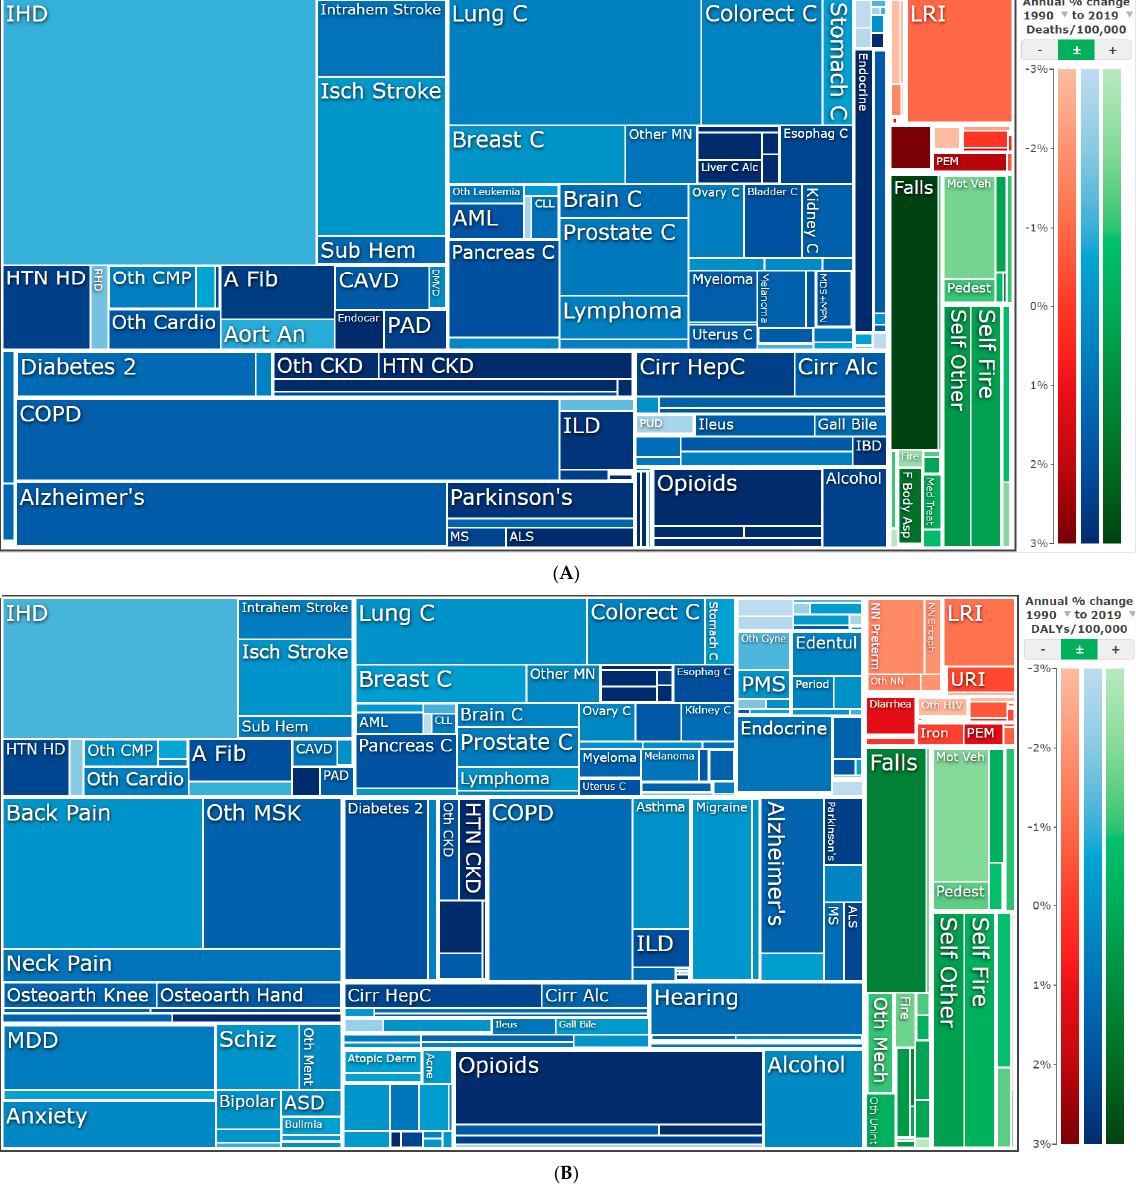
Figure 1. Tree maps of causes of ( A ) death and ( B ) disability-adjusted life years (DALYs) in Colorado, both sexes, all ages, in 2019. Blue rectangles are non-communicable disease; red rectangles are communicable; and green rectangles are injuries. Darker colors represent an increase in disease and the lighter colors show a decrease. The size of the boxes represents overall disease burden (the larger the rectangle, the greater the burden of that disease regardless of increase/decrease). Institute for Health Metrics and Evaluation (IHME). GBD Compare Data Visualization. Seattle, WA: IHME, Uni ‐